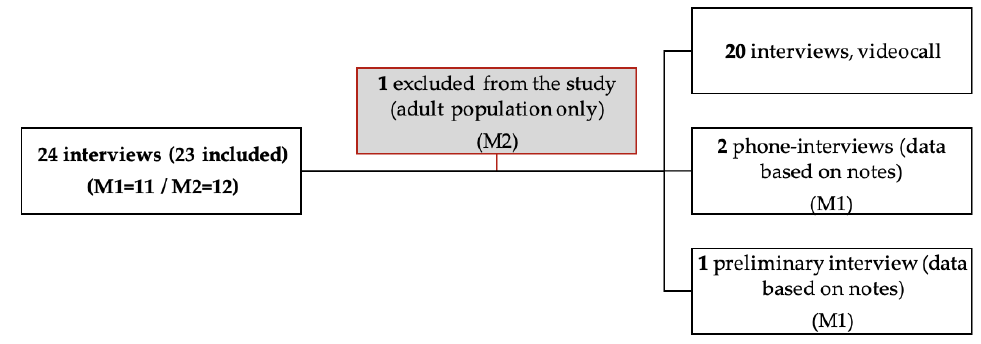
Figure 1. Flowchart, interviews